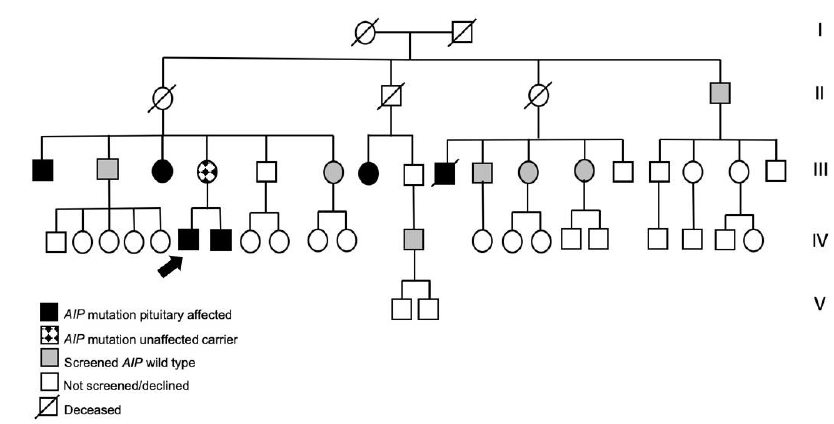
Figure 2. Genealogic tree of the aryl hydrocarbon receptor interacting protein ( AIP ) gene mutation - positive familial isolated pituitary adenoma (FIPA) kindred. The index case (IV-6) is indicated by a black arrow. Generations I through V are highlighted on the right of the figure.